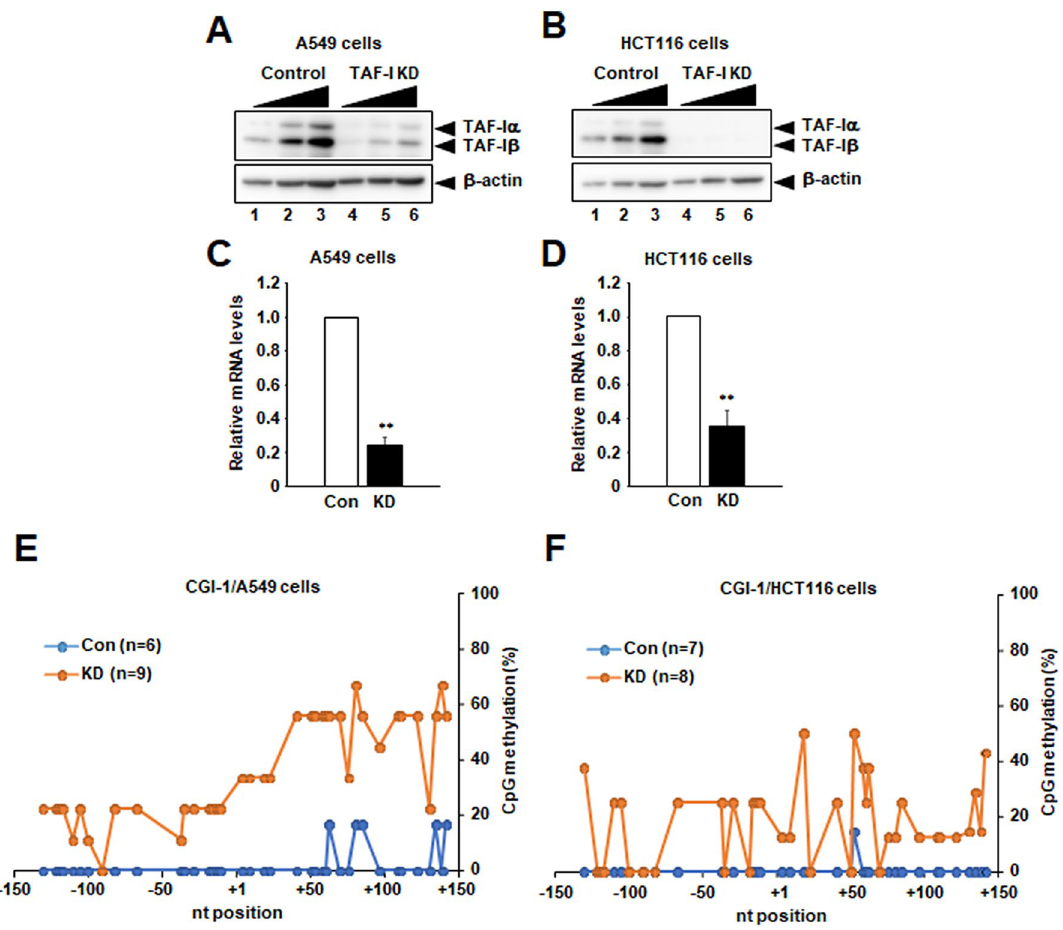
Figure 8. Downregulation of TERT transcription by TAF-I KD was observed in several cancer cells. ( A , B ) TAF-Iα and TAF-Iβ expression levels were examined by western blotting analyses. Total cell extracts prepared from control (lanes 1–3) and TAF-I KD (lanes 4–6) A549 cell lines ( A ), control (lanes 1–3) and TAF-I KD (lanes 4–6) HCT116 cell lines ( B ) were separated on 10% SDS-PAGE followed by western blotting analyses using anti- TAF-Iα/β and anti-β-actin antibodies. Five (lanes 1 and 4), ten (lanes 2 and 5) and twenty (lanes 3 and 6) µg of total protein prepared from each cell line was loaded. ( C , D ) The expression level of TERT mRNA was examined. Total RNA was isolated from control (Con) and TAF-I KD (KD) A549 cells ( C ) or HCT116 cells ( D ), and were subjected to Q-RT-PCR analyses to examine the expression level of TERT mRNA. The 18S rRNA was used for normalization as an internal control. Values represent the mean ± SD (n = 3). ** P < 0.01 relative to respective control cells. ( E , F ) Bisulfite sequencing analyses. The methylation level of each CpG dinucleotide in CGI-1 of TERT was compared between control and TAF-I KD A549 cells ( E ) or HCT116 cells ( F ). The horizontal line indicates nucleotide positions from the TERT TSS, and the vertical line indicates the percentage of CpG